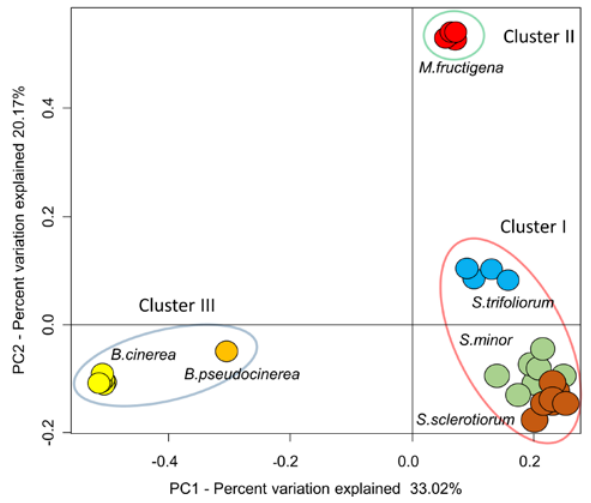
Figure 3. Association matrix for six fungal species, based on principal coordinate